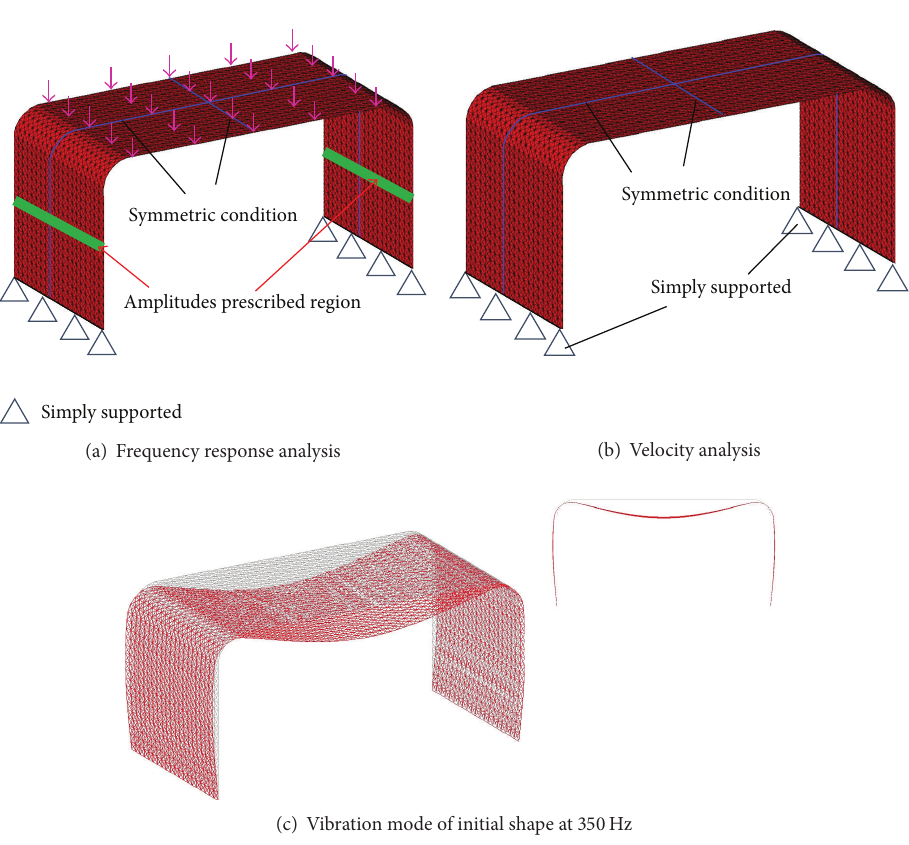
Figure 9: Initial shape and boundary conditions of table-shaped model (350